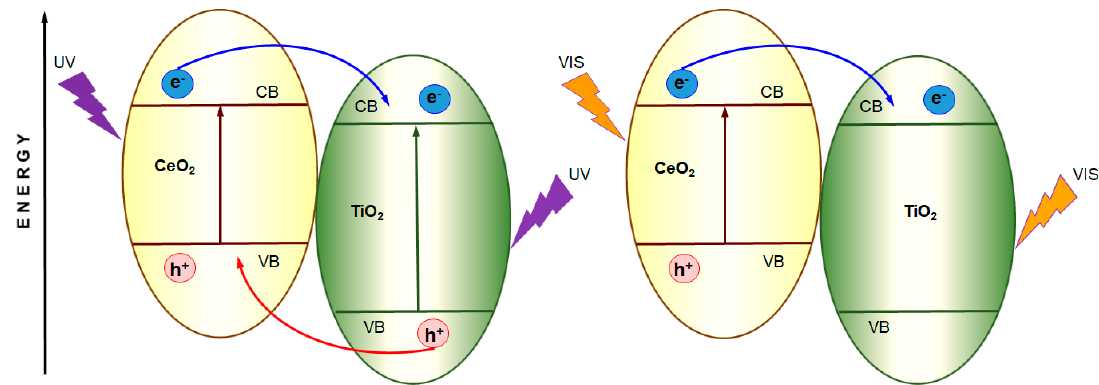
Figure 4. A schematic diagram of CeO 2 / titanium dioxide (TiO 2 ) composite photoexcitation under UV and VIS light